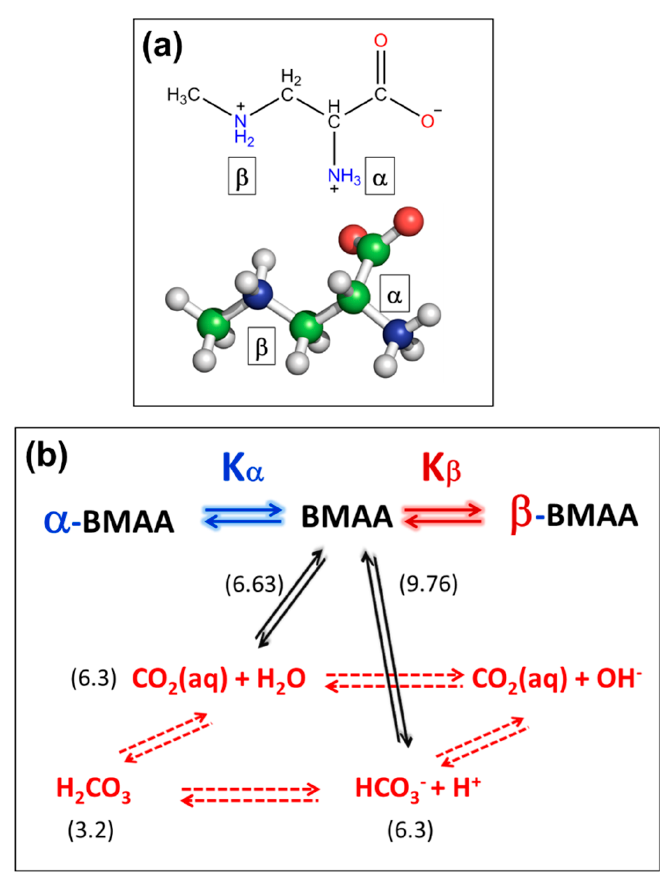
Figure 3. β -N-methylamino-L-alanine (BMAA) and carbamate formation. ( a ) Chemical and three-dimensional structure of BMAA. ( b ) Intermolecular exchange mechanism for the dynamic equilibria of BMAA. The equilibria between CO 2 , H 2 CO 3 , and HCO 3 − are shown in red, while the equilibrium between BMAA and its carbamates are shown in black. The pKa value of each reaction is given in parenthesis. The subscripts α and β represent the primary and secondary carbamates of BMAA. Figure reproduced with permission [49].